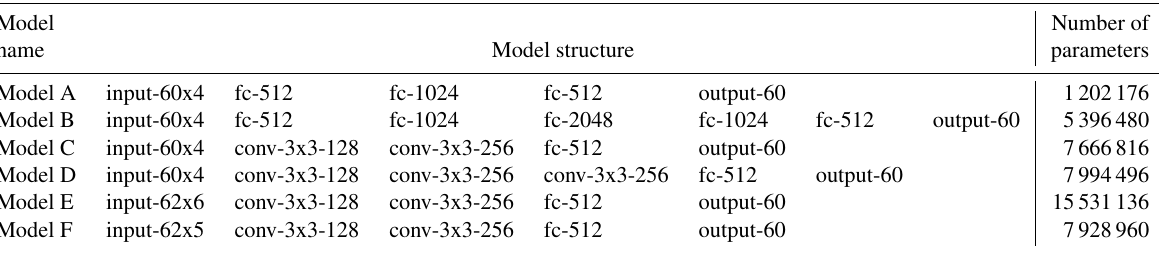
Table 1. Neural network models used for predicting RTs. “fc-X” represents a fully connected layer with X number of neurons.“1conv-YxY- X” represents a convolutional layer with X number of YxY filters.